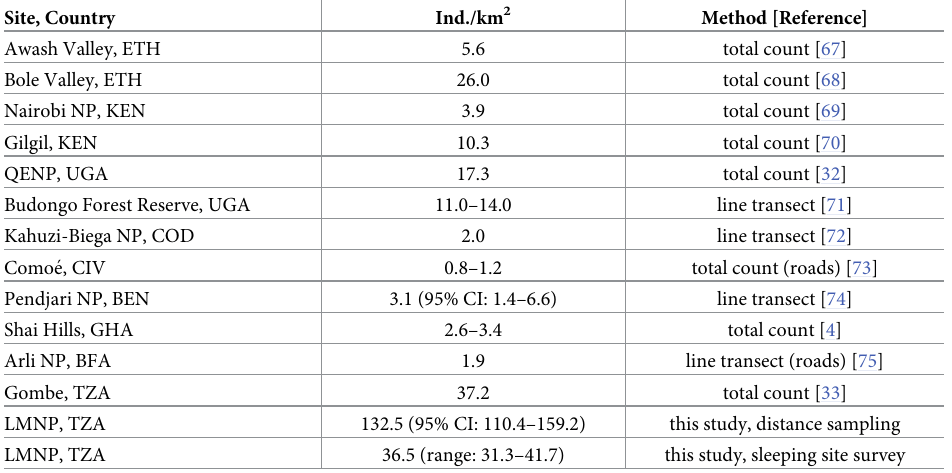
132.5 (95% CI: 110.4–159.2) this study, distance sampling LMNP, TZA 36.5 (range: 31.3–41.7) this study, sleeping site survey BEN = Benin, BFA = Burkina Faso, CIV = Coˆte d’Ivoire, COD = Democratic Republic of the Congo, ETH = Ethiopia, GHA = Ghana, KEN = Kenya, TZA = Tanzania, UGA = Uganda, QENP = Queen Elizabeth National Park, LMNP = Lake Manyara National